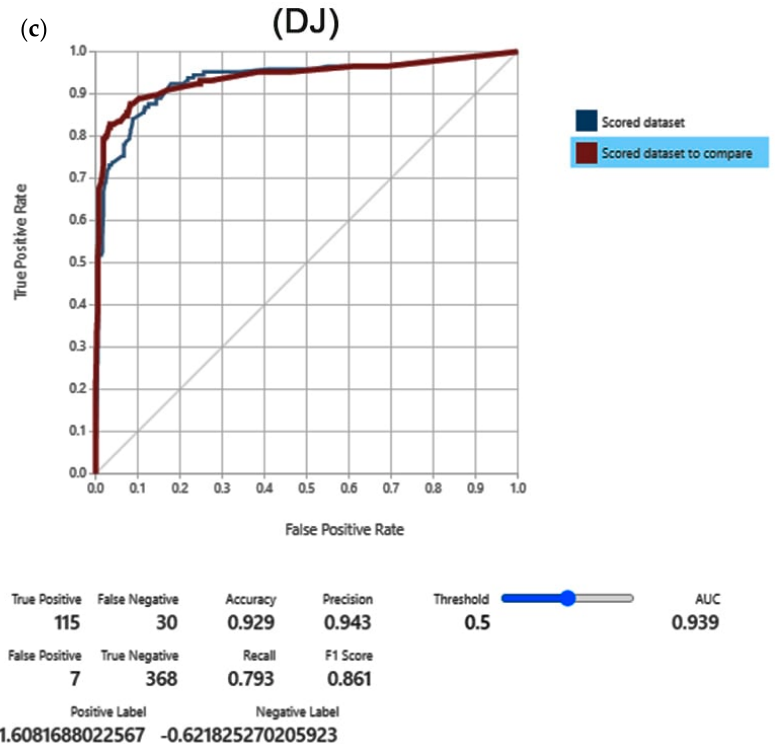
Figure 10. ( a ) Validation results (testing stage) for AP, BPM, LR, ANN. ( b ) Validation results (testing stage) for BDT, DF, LD-SVM, and SVM. ( c ) validation results (testing stage) for DJ model.